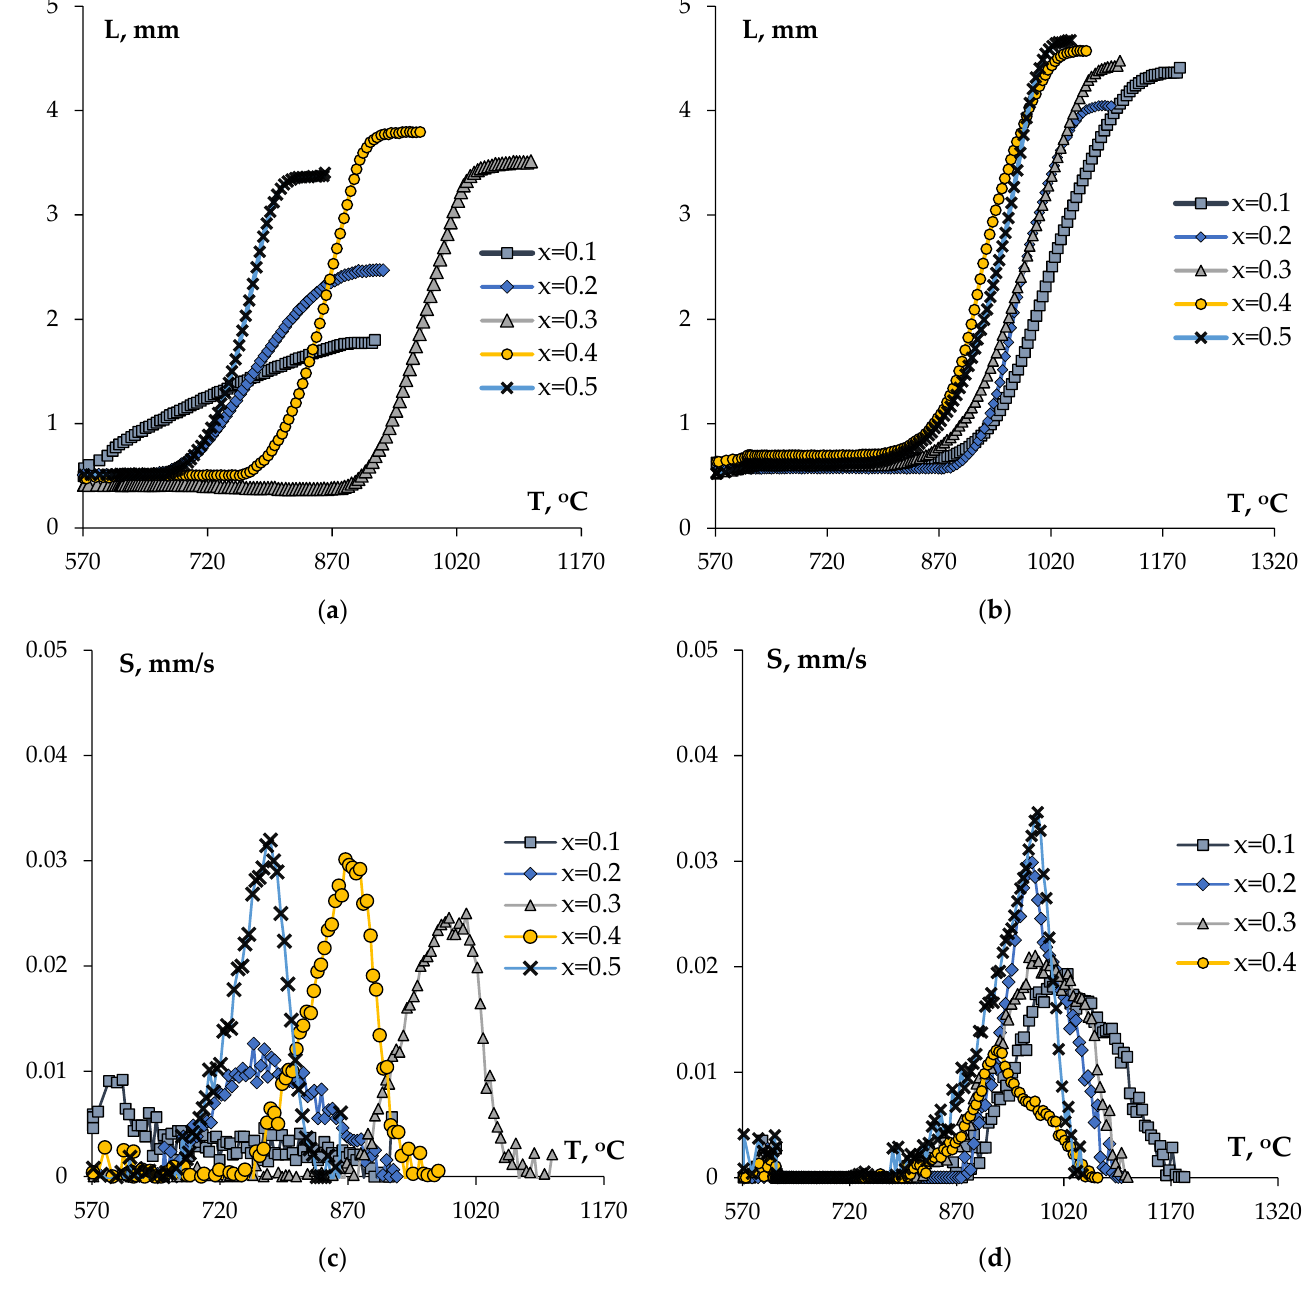
Figure 14 . SPS diagrams L(T) ( a , b ) and S(T) ( c , d ) for the Na 1-x Zr 2 (PO 4 ) 3-x (XO 4 ) x ceramics, X = Mo ( a , c ), W ( b , d ).